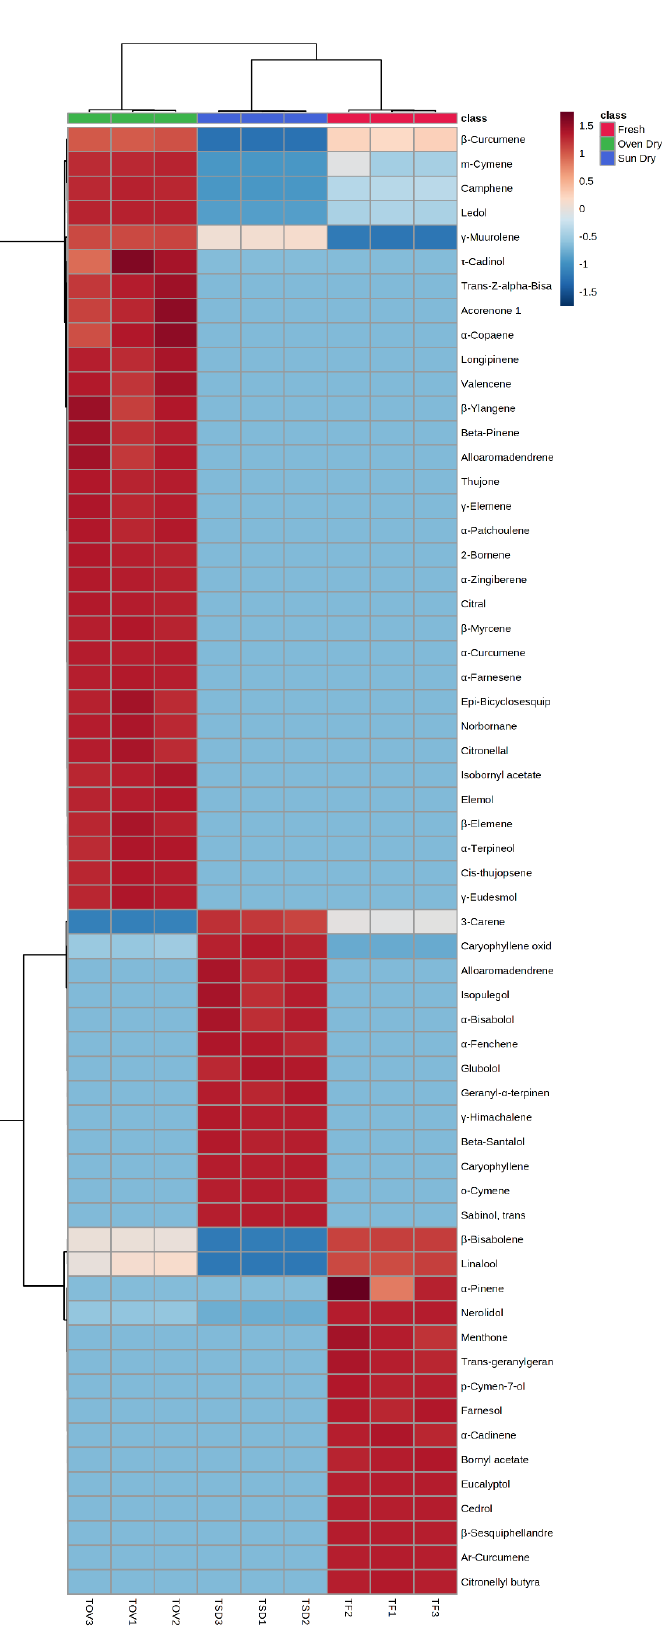
Figure 8. Heat maps showing the major class of compounds in fresh, oven-dried, and sun-dried Thailand ginger